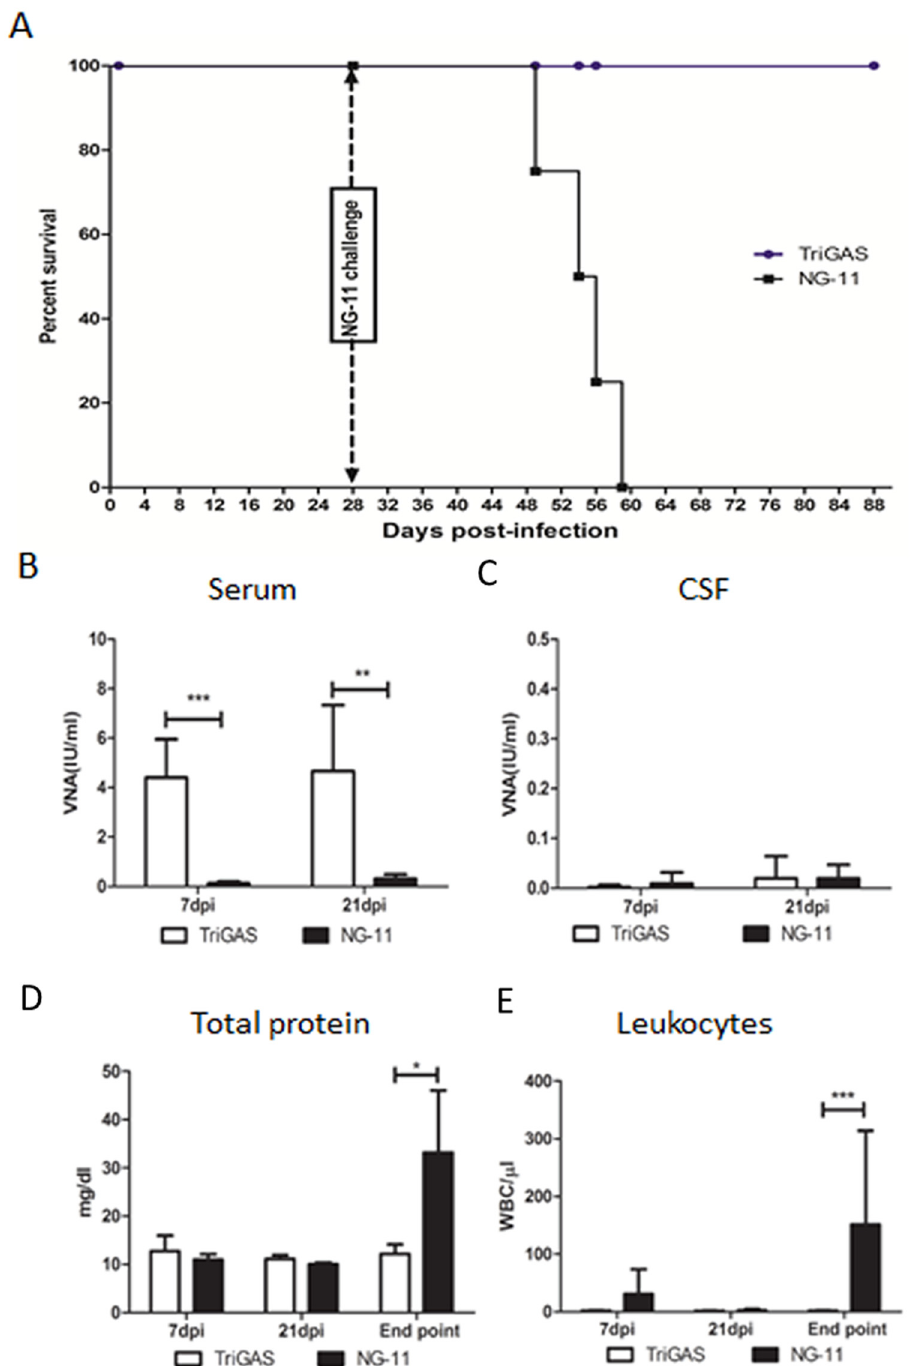
Fig 1. (A) Group of dogs were IM infected with a single dose of 10 7 FFU of live-attenuated TriGAS. At 4 weeks after immunization dogs were challenged IM with 200 MICLD 50 of DRV-NG11. As control, group of unvaccinated dogs were infected IM with 200 MICLD 50 of DRV-NG11, and their survivorship were recorded for 60 days. (B) VNA in the serum. (C) VNA in the CSF. (D) Analysis of CSF total proteins. (E) Leukocytes in the